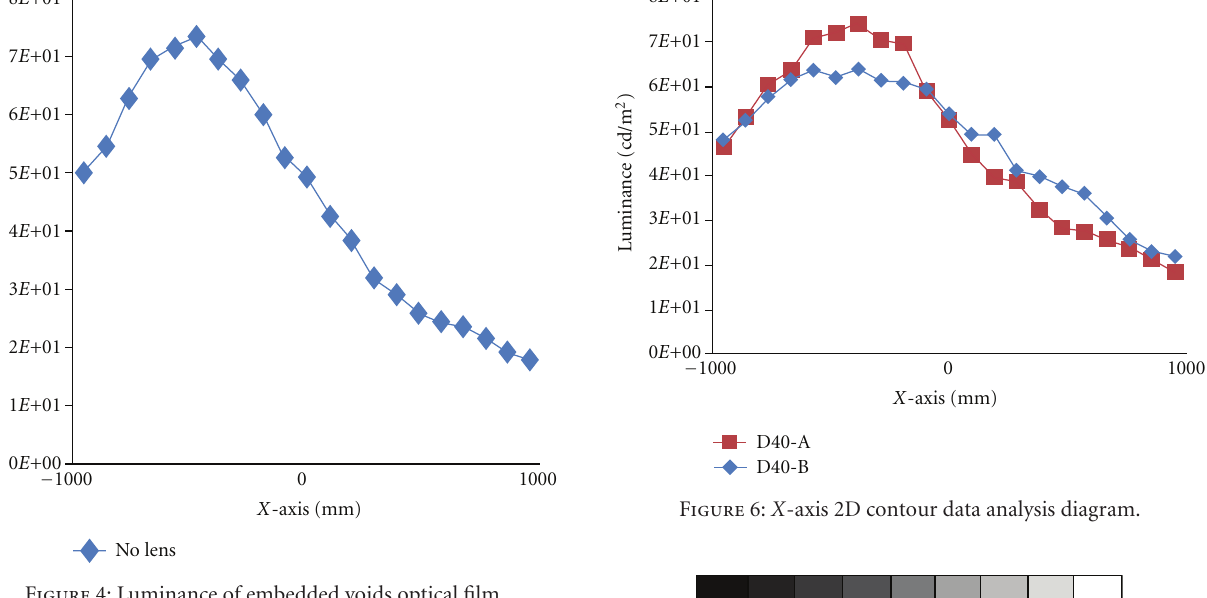
Figure 4: Luminance of embedded voids optical film.